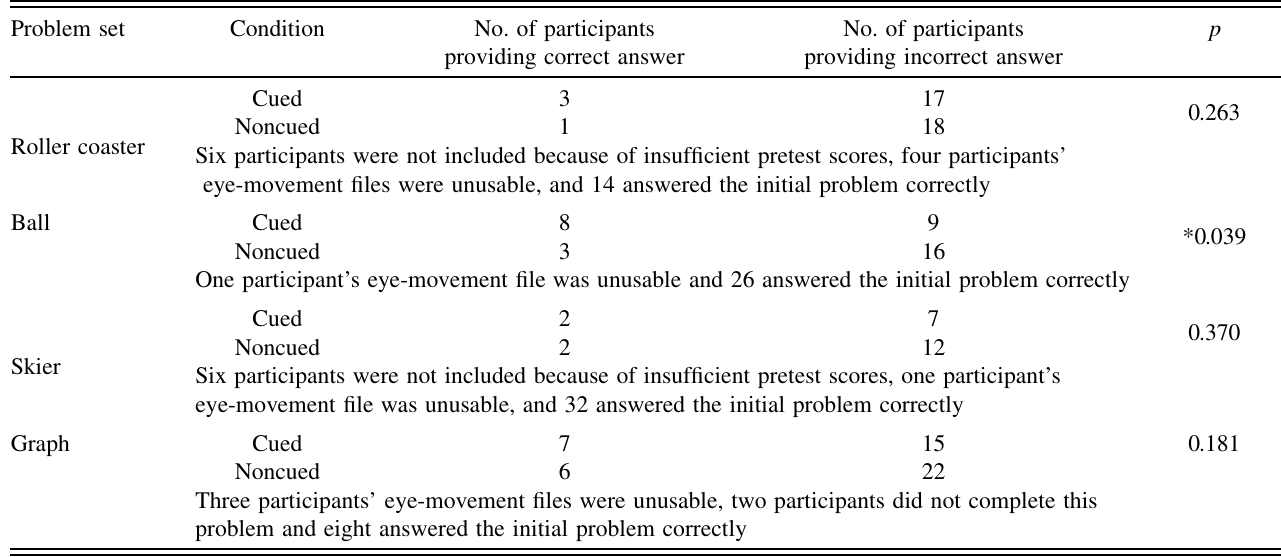
TABLE III. Summary of results of Fisher’s exact test comparing those who did and did not answer the transfer problem correctly for the cued and noncued conditions. An asterisk indicates a significant difference at the (cid:1) ¼ 0 : 05 level Problem